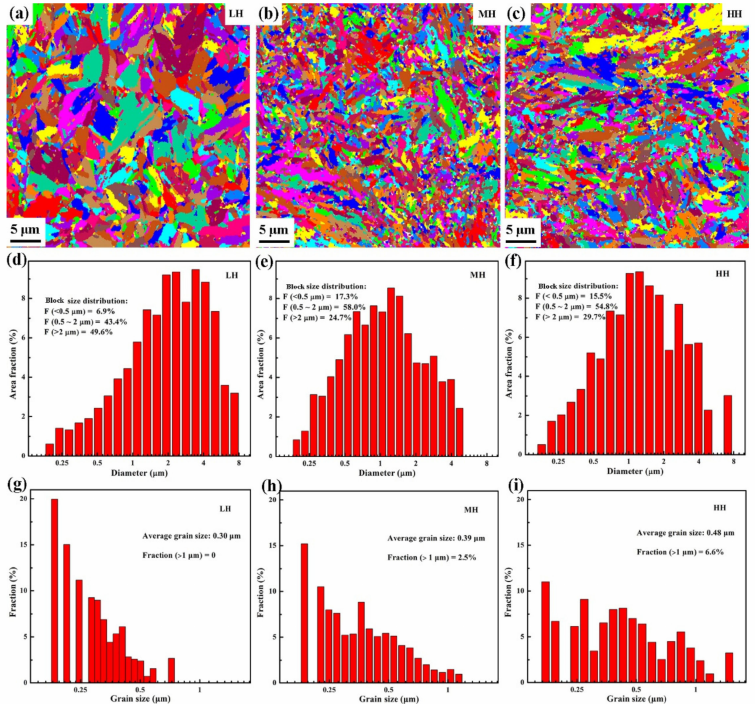
Figure 5. ( a – c ) Martensitic block maps. ( d – f ) The corresponding block size distributions. ( g–i ) The grain size distributions of retained austenite of SLM-processed LH, MH, and